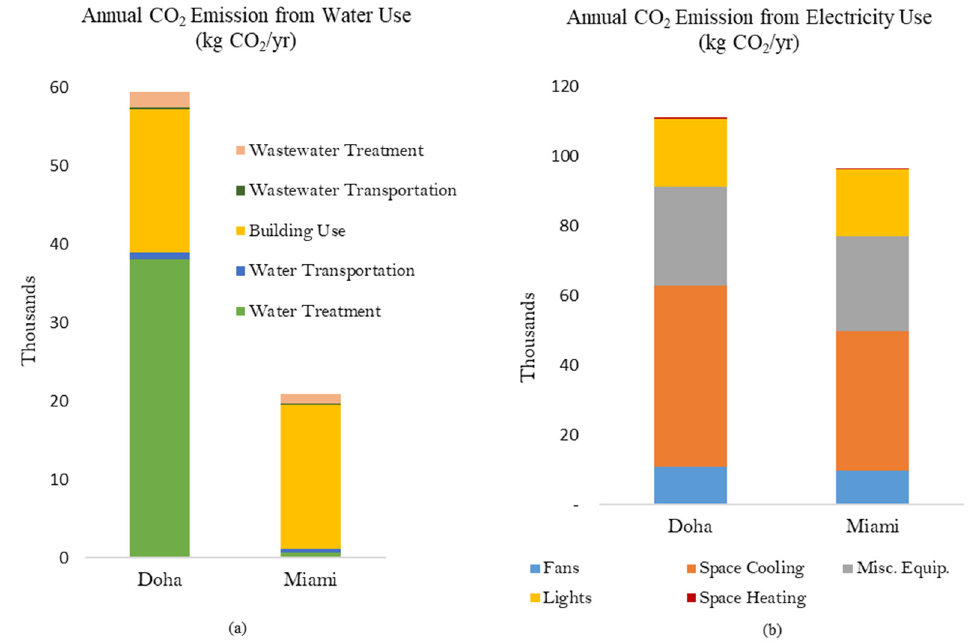
Figure 7. Annual CO 2 emission from three water-use stages and electricity use in two case study buildings. ( a ) clearly shows the main variance generated from the raw water treatment and distribu- tion stage for Doha, where the other two stages resulted in similar emission scores. ( b ) represents the CO 2 emission potential for case study building in both locations for annual electricity use.